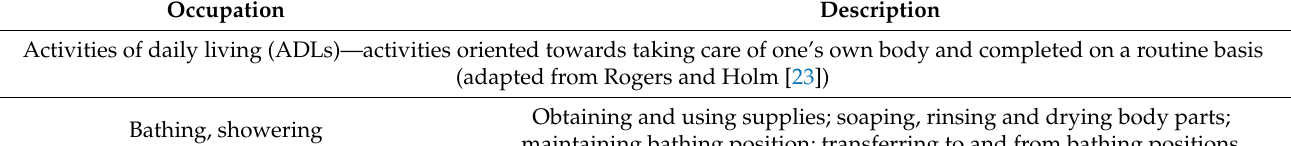
Table 1. Children’s occupations in home context are categorised as activities of daily living, rest and sleep and play (adapted from OTPF 4th